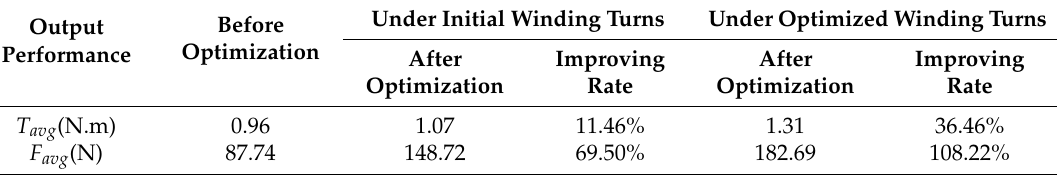
Figure 12. Comparison of machine torque and suspension performance before and after optimization: ( a ) torque characteristic; ( b ) suspension force characteristic. Table 7. Numerical comparison of machine output performance before and after optimization.